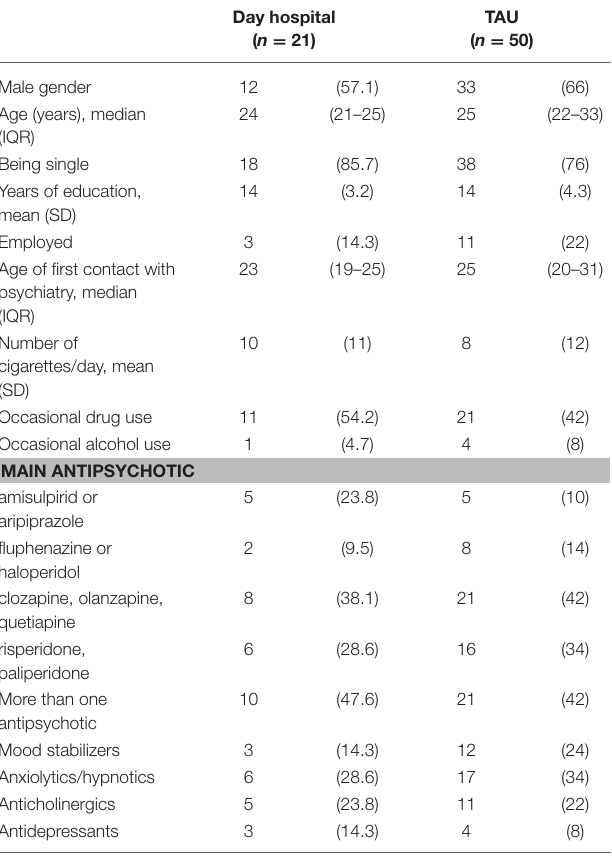
TABLE 1 | Baseline participants’